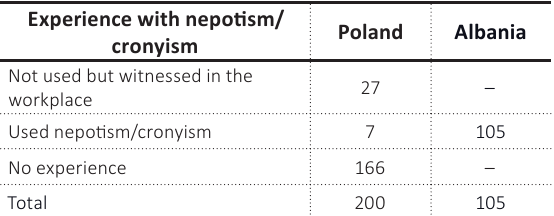
Table 1. Experience with nepotism and cronyism Experience with